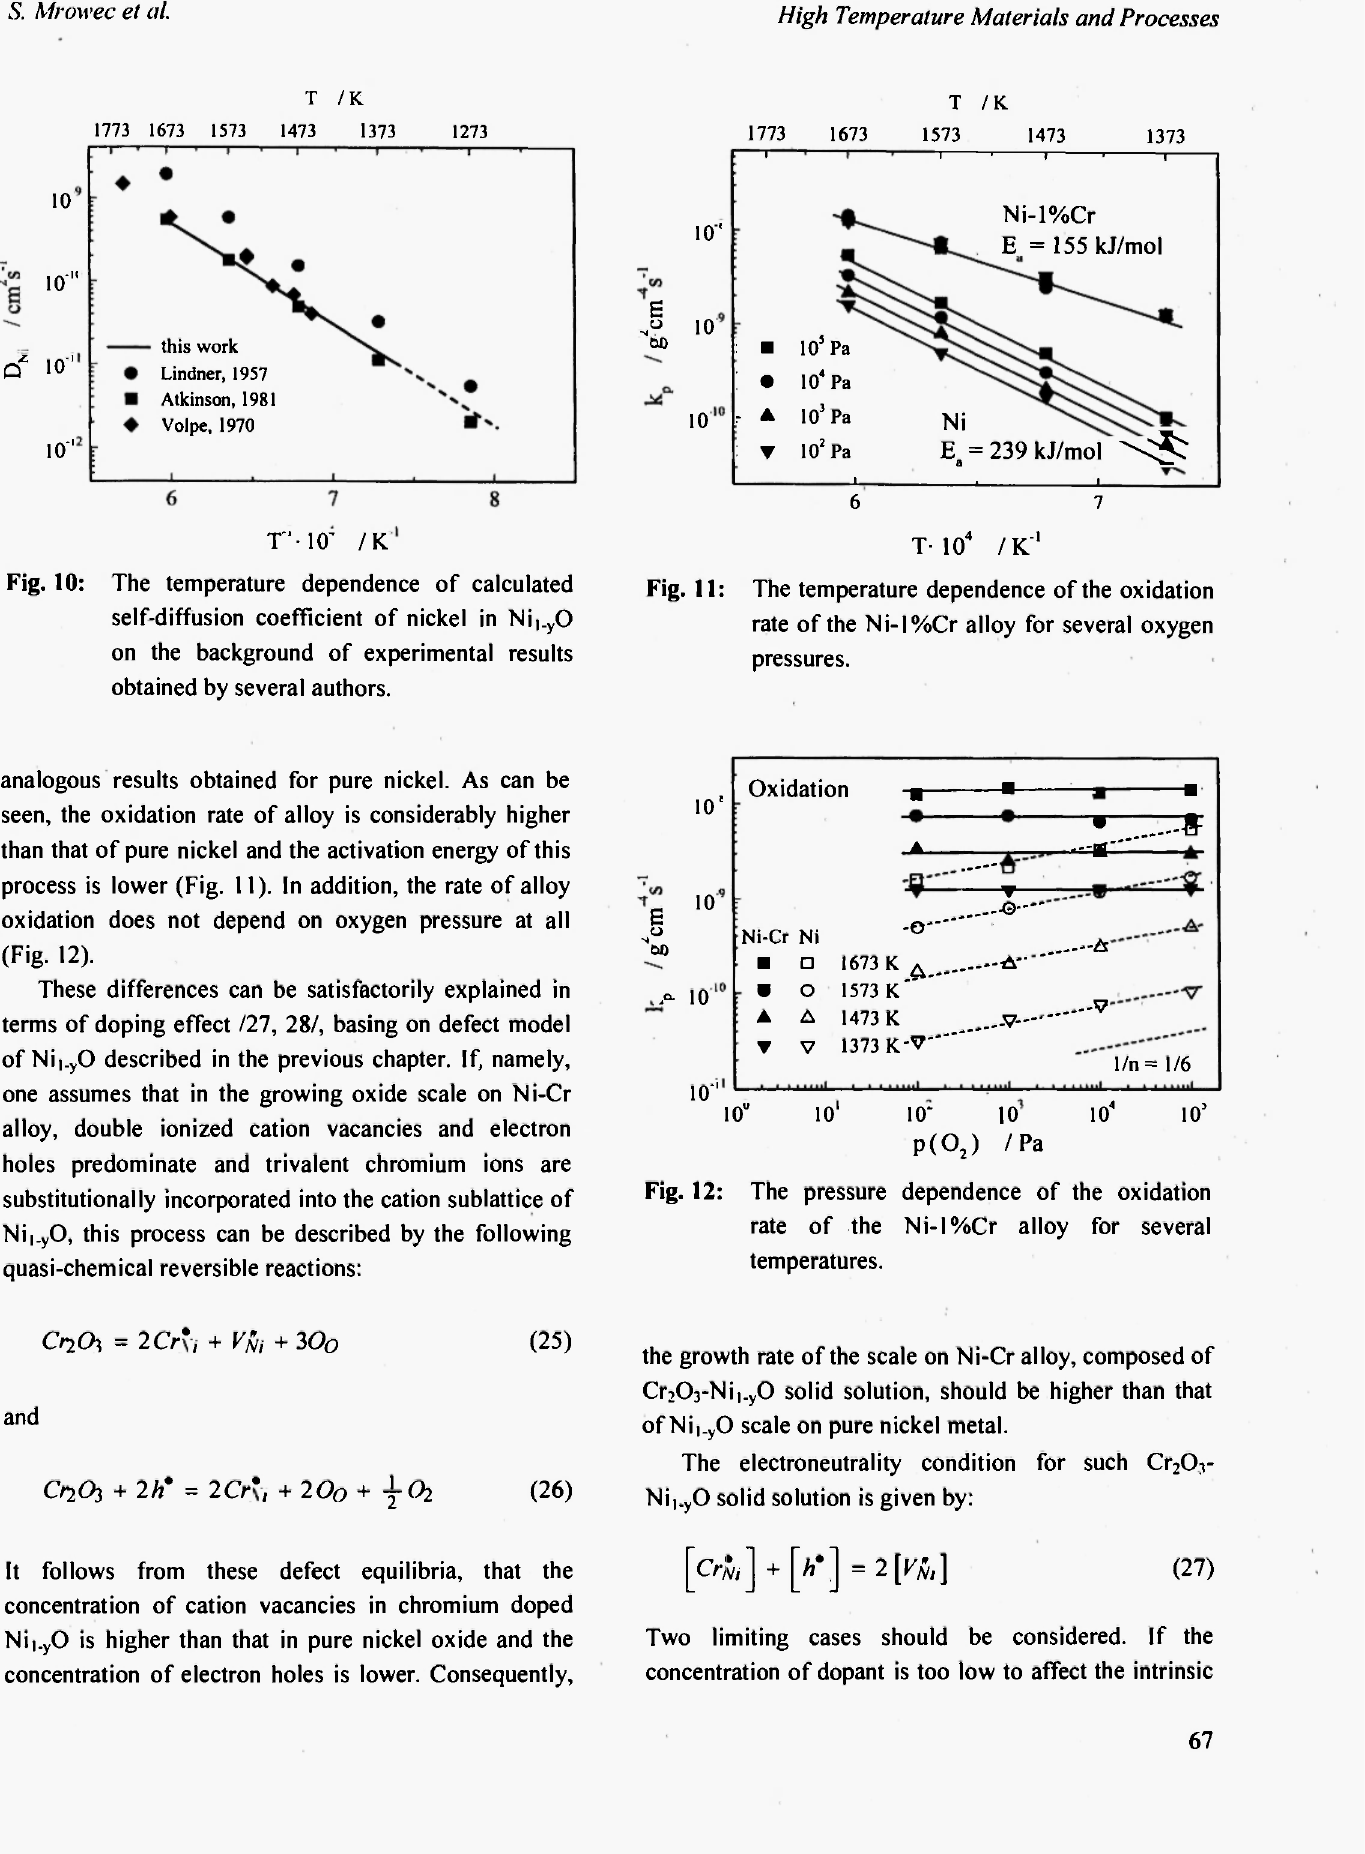
Fig. 11: The temperature dependence of the oxidation rate of the Ni-l%Cr alloy for several oxygen pressures.